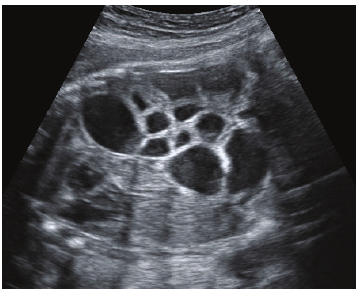
Figure 1: Dilated bowel loops seen in 30th-week gestation.